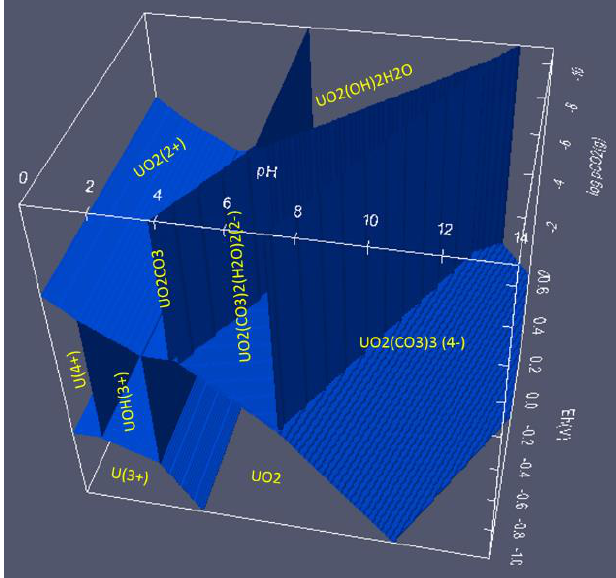
Figure 34. Eh-pH-logpCO 2 (g) of uranium where the species are shown by colors. This diagram matches Figure 7.32a of Garrels and Christ.